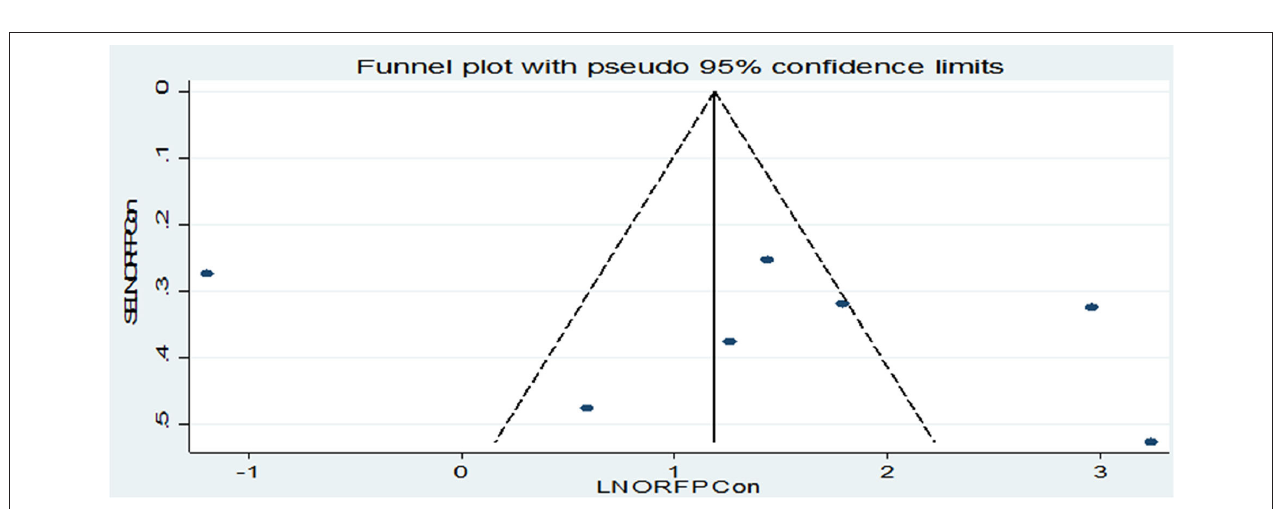
FIGURE 8 | Funnel plot for publication bias, LNORFPCON represented in the x -axis and standard error of SELNORFPCON on the y -axis.